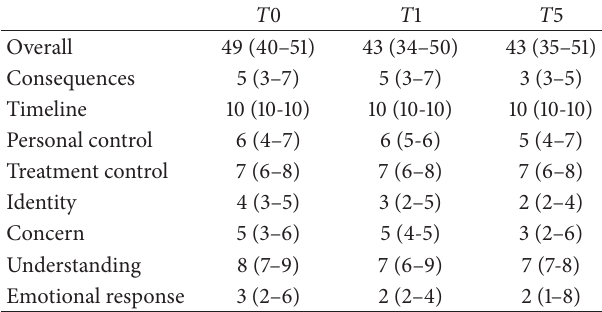
Table 4: Brief IPQ median values (interquartile range). T 0 T